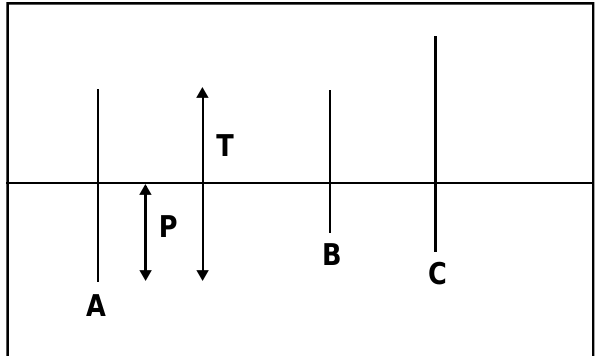
Figura 1. A razão de horizonte é definida por T/P, onde T corresponde ao tamanho total do objeto e P ao tamanho parcial do objeto que fica abaixo da linha do horizonte. O objeto A tem duas vezes a altura do ponto de observação (razão de horizonte = 2). Os objetos B e C têm três vezes a altura do ponto de observação (razão de horizonte = 3). Conseqüentemente, os objetos B e C têm uma vez e meia a altura do objeto A (baseado em Rogers,